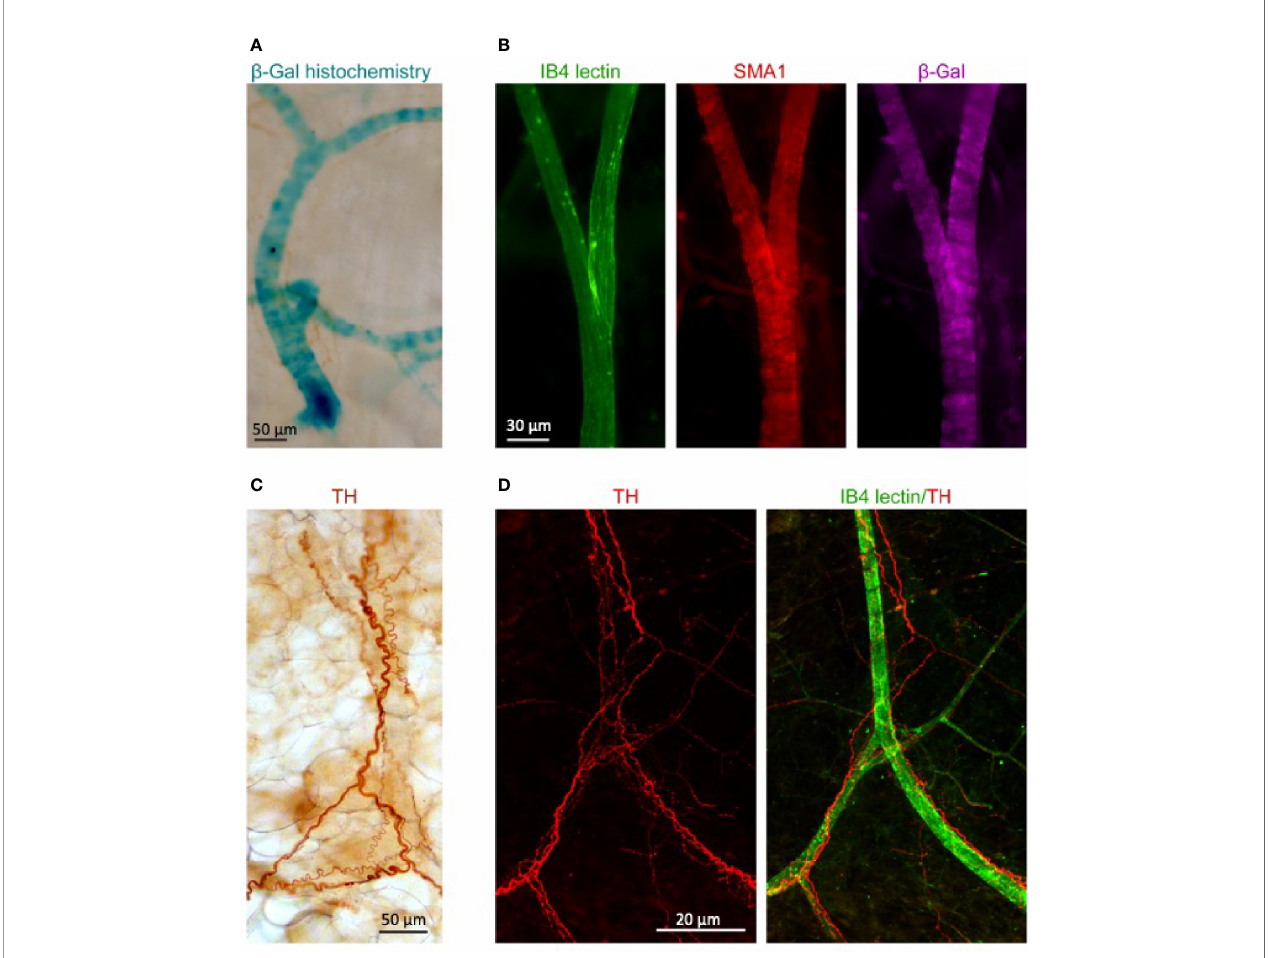
FIGURE 3 | Blood vessels irrigating WAT express NT3 and are in close association with sympathetic fi bers. (A) b -galactosidase ( b -gal) histochemistry in WAT from NTF3 +/lacZneo mouse showed a staining pattern consistent with blood vessels. (B) Immuno fl orescence against SMA1 (red) and b -gal (purple) in mice transcardially injected with FITC-labeled lectin IB4 (green). Speci fi c staining of b -gal was observed in blood vessels. (C) Immunoperoxidase detection of tyrosine hydroxylase (TH) and (D) immuno fl urescent detection of TH (red) and FITC- lectin IB4 (green). Sale bars: (A) 50 µm, (B) 30 µm, (C) 50 µm, and (D) 20